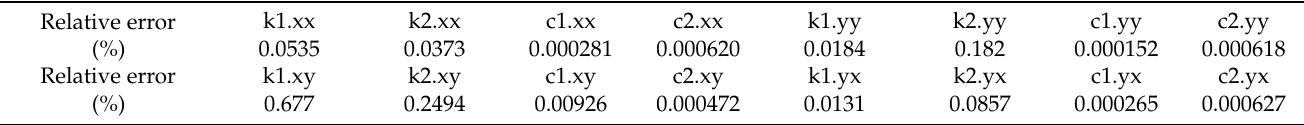
Table 17. The biggest identification error using the computational example